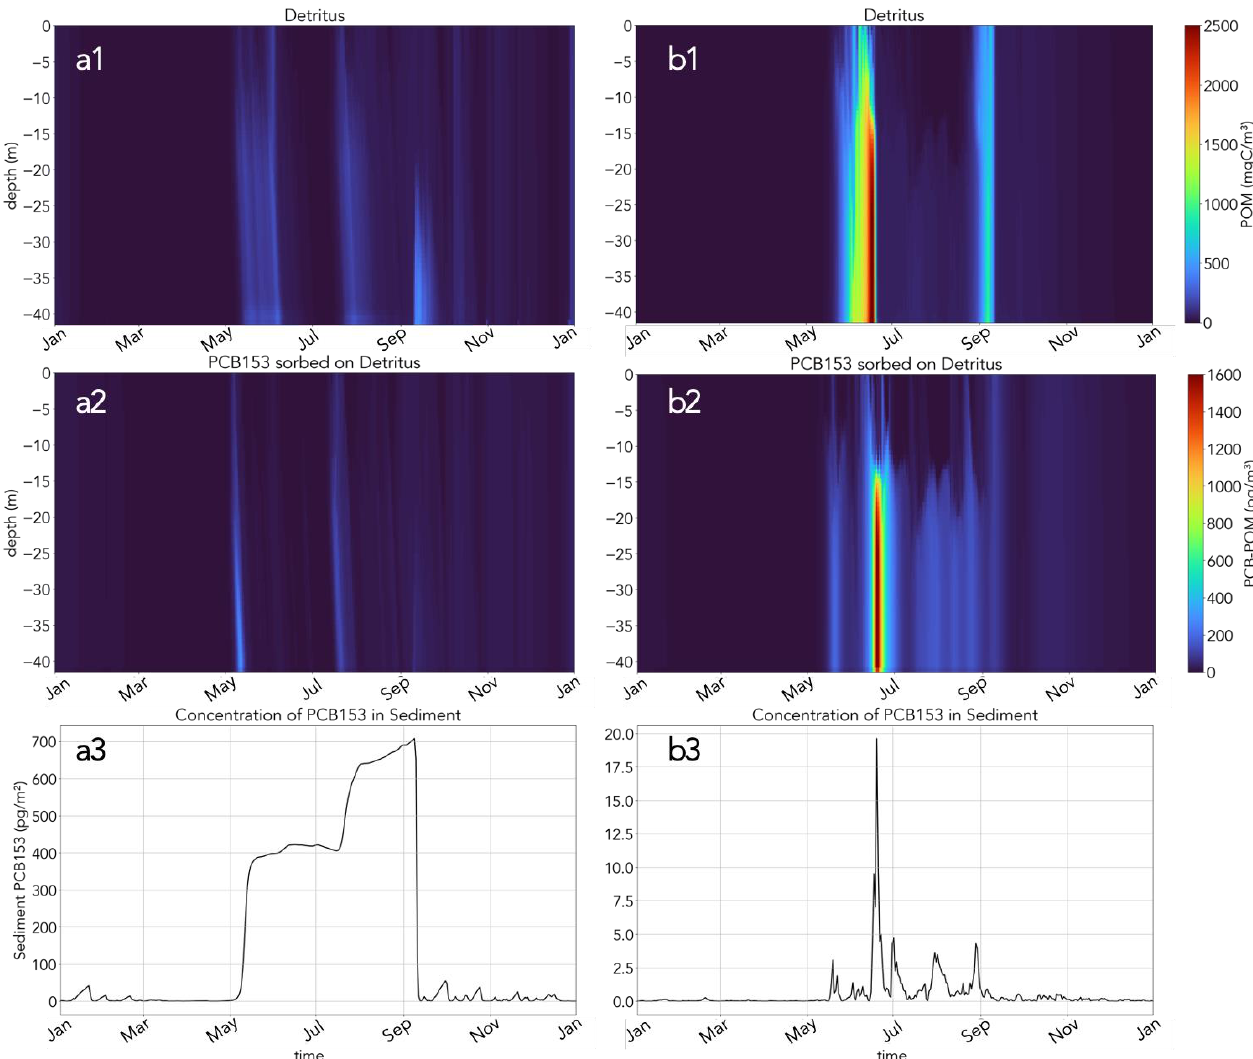
Figure 13. Results of simulations for ( a1 , a2 , a3 ) no-tide scenario, ( b1 , b2 , b3 ) tide scenario (SNS, 2001 year). Concentrations of ( a1 , b1 ) detritus (mgC m −3 ); ( a2 , b2 ) PCB POM (pg m −3 ); ( a3 , b3 ) PCB in sediments (pg m −2 ).